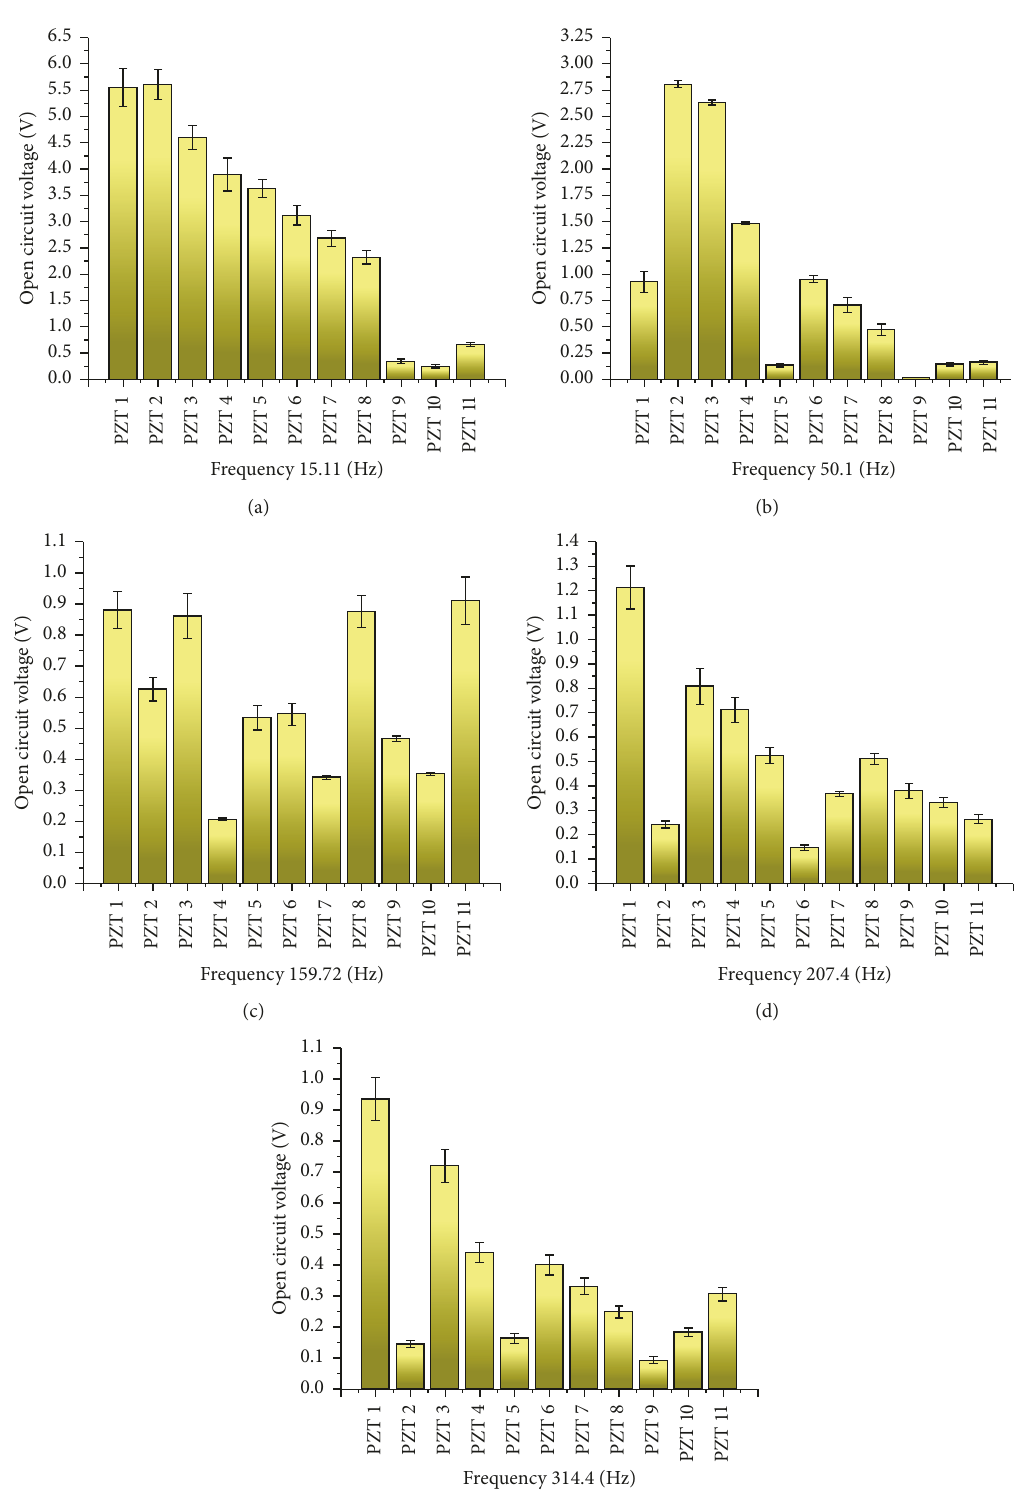
Figure 13: Open circuit voltage characteristics at the resonant frequencies: at (a) 15.11Hz; (b) 50.1 Hz; (c) 159.72 Hz; (d) 207.4 Hz; (e) 314.4